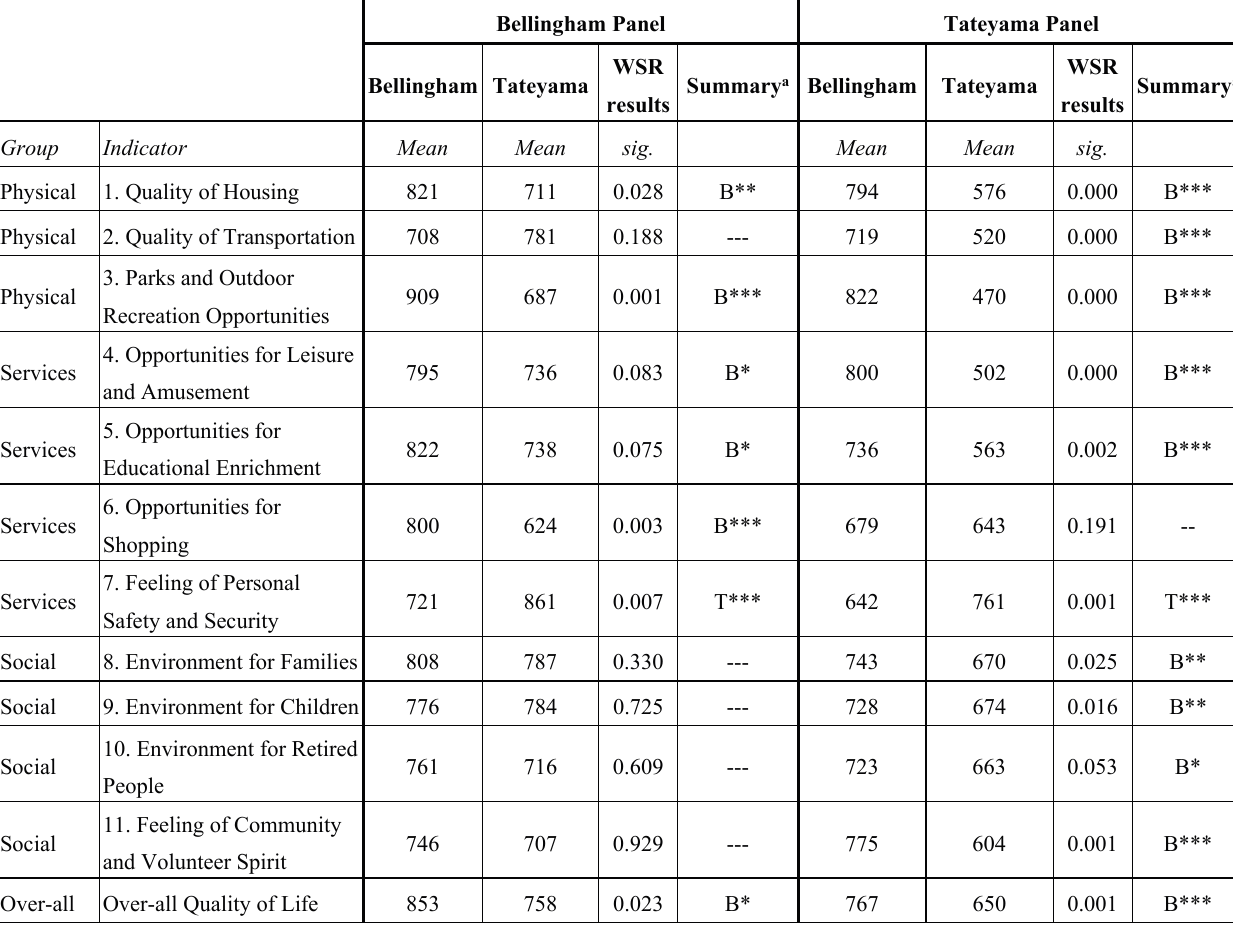
Table 1. Average of QOL indicators by panel between cities and Wilcoxon Signed Ranked (WSR) Test